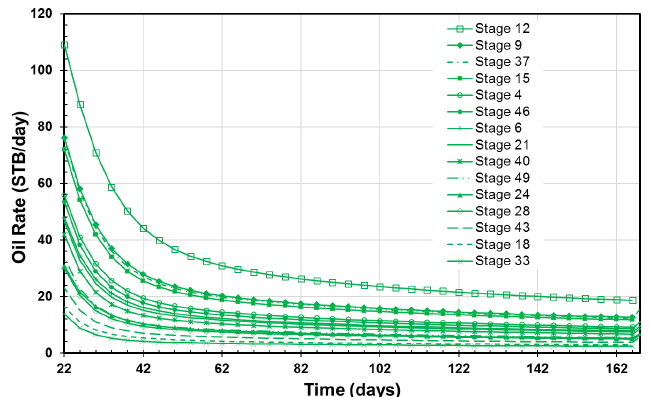
Figure 12. Stage-by-stage oil production rate forecast for the 15 stages in Tables 5 and 6. The legend is arranged to correspond with the well performance ranking. Stage 12 performs the best while Stages 18 and 33 are the poorest.